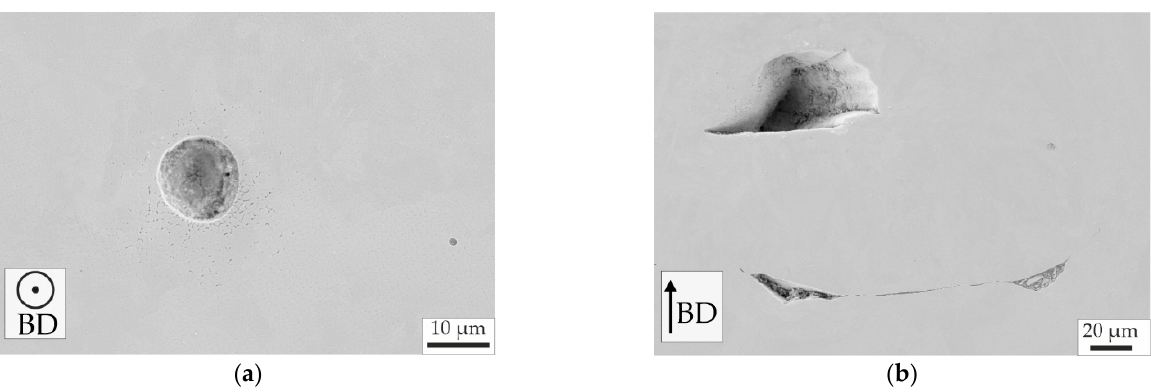
Figure 3. Typical LPBF defect types identified for the FeMnCS alloy with ( a ) small round-shaped entrapped gas pores and ( b ) sharp-edged crescent formed binding defects between consecutive LPBF layers.